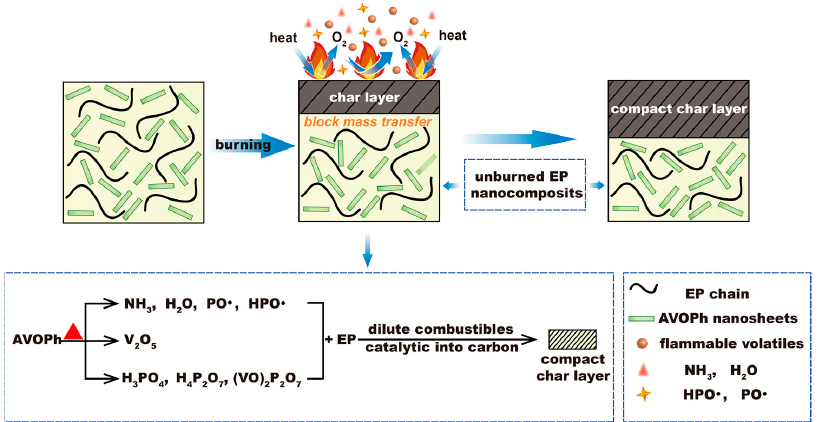
Figure 7. Schematic illustration of the mechanism for the enhanced fl ame resistance of EP/AVOPh Figure 7. composites.